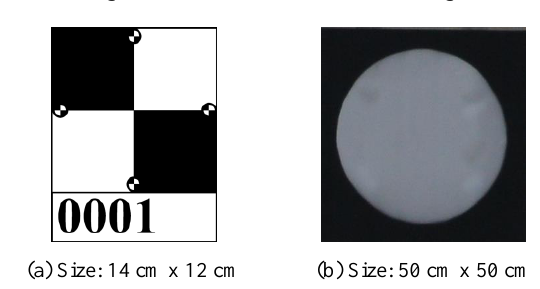
Figure 3. GPSVan at the calibration range.